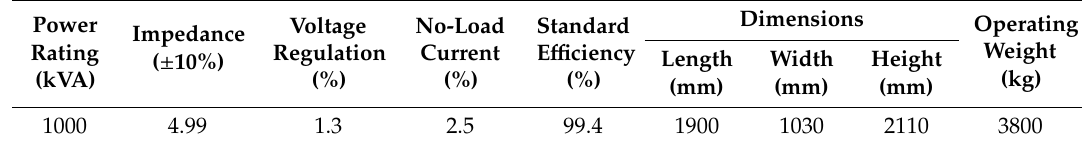
Table 1. Detailed specifications of the prototype mold